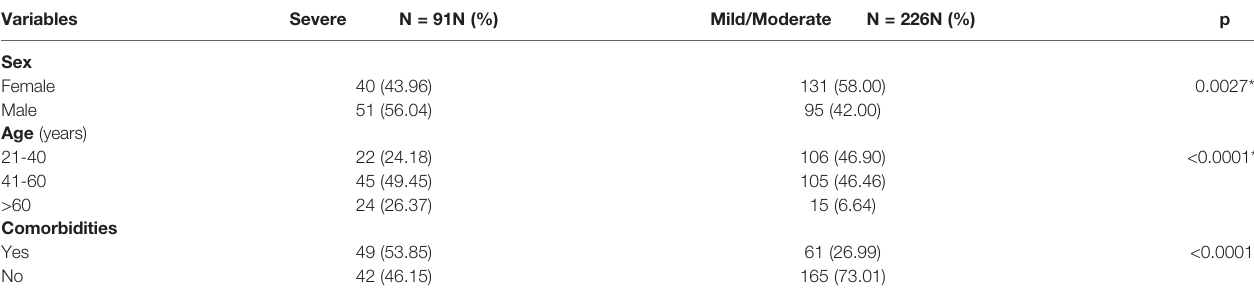
TABLE 2 | Distribution of frequencies of epidemiological variables between groups with different clinical conditions of COVID-19. Variables